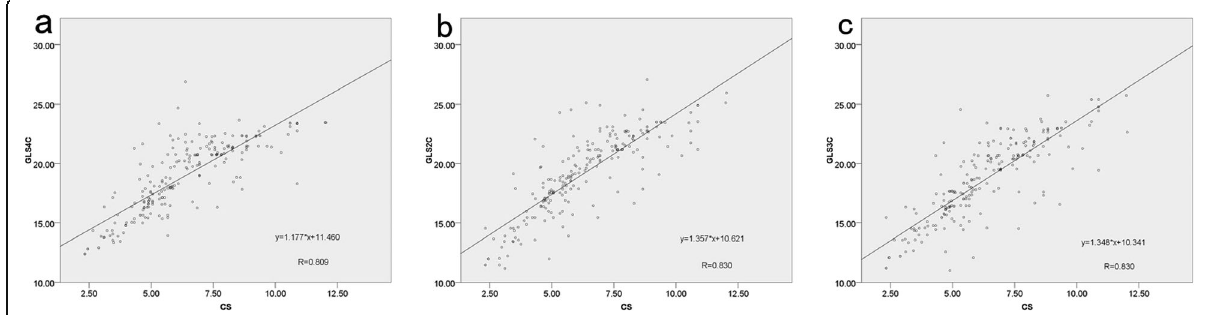
Fig. 5 Correlations between the CS and the GLS of apical, four-chamber view ( a ), two-chamber view ( b ), and three-chamber view ( c